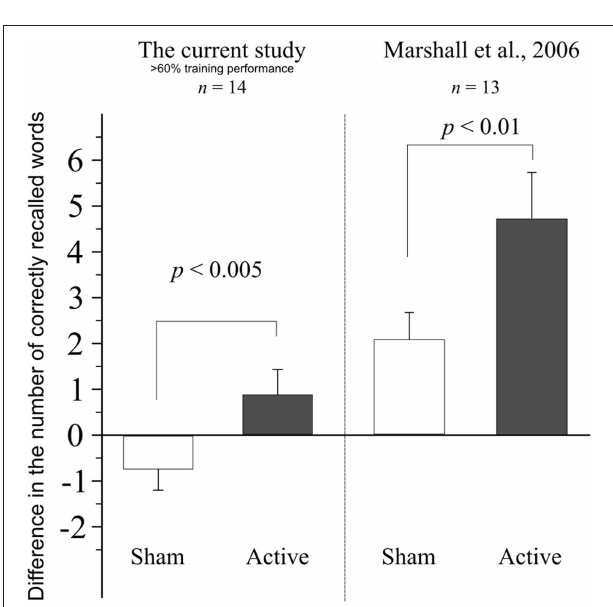
FIGURE 3 | Difference in performance between the evening and morning sessions, when data from subjects performing under 60% in the training session of either sham or active stimulation session are retrospectively removed. Data from Marshall et al. (2006) shown for comparison. Error bars denote